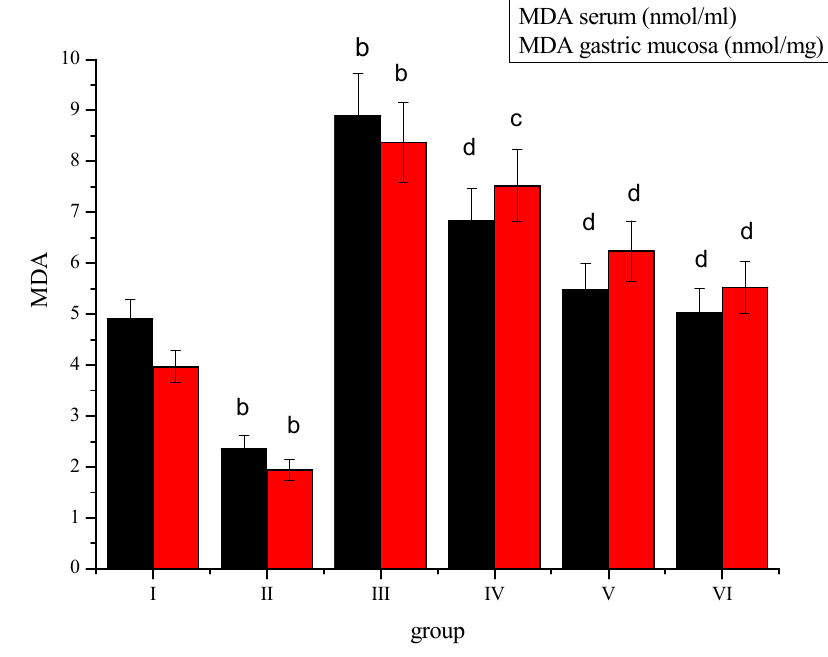
Figure 3. Effect of Sargassum pallidum aqueous extract on serum and gastric mucosa MDA level in different